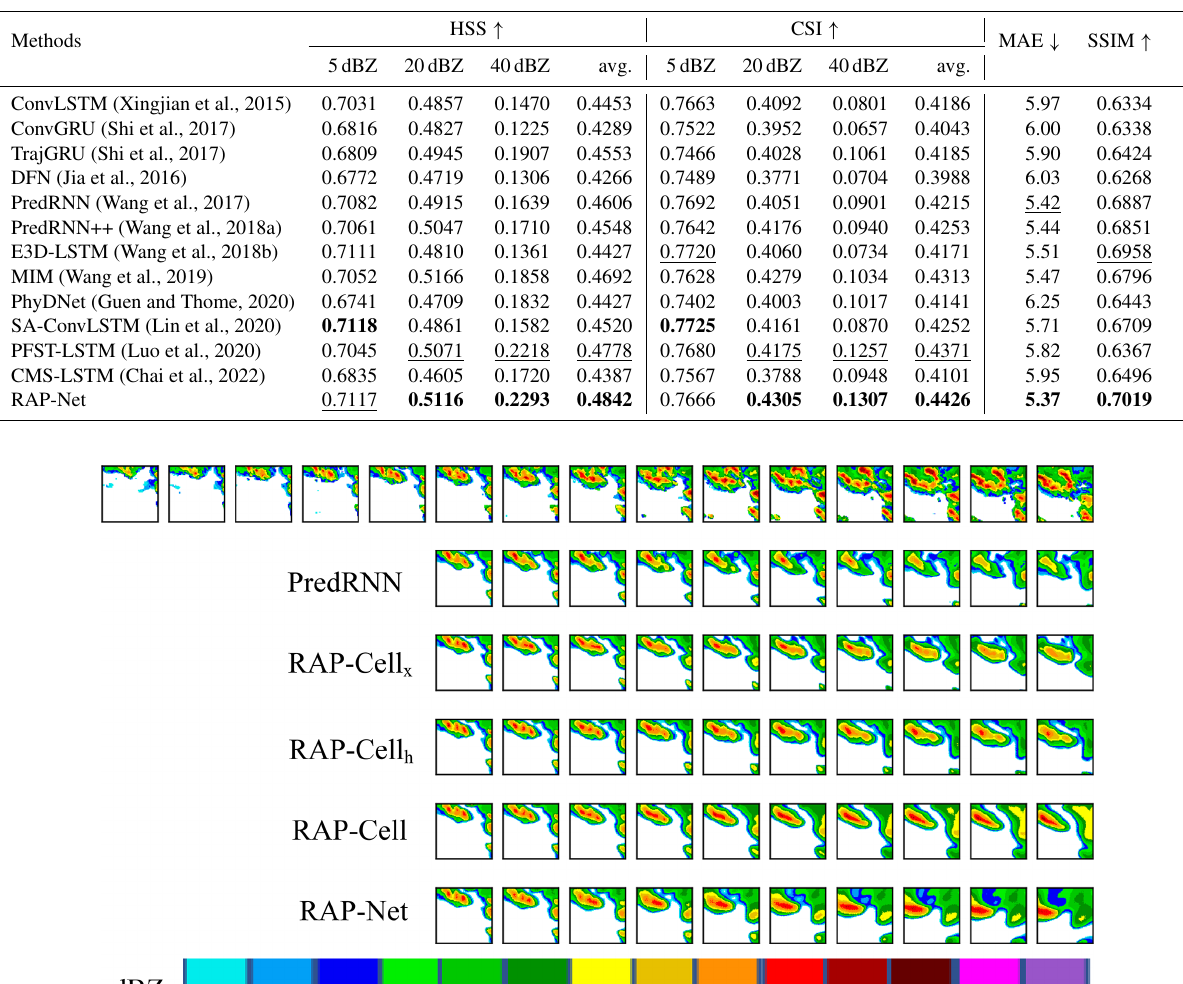
Table 2. Comparison results on RadarCIKM in terms of HSS, CSI, SSIM, and MAE. The best results are given in bold, and the second-best scores are underlined.